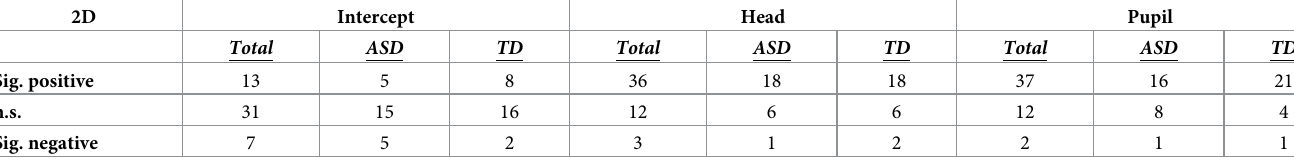
Table 1. Number of individuals with significant effects of intercept, head, and pupils in 2D. 2D Sig. positive n.s. Sig. negative